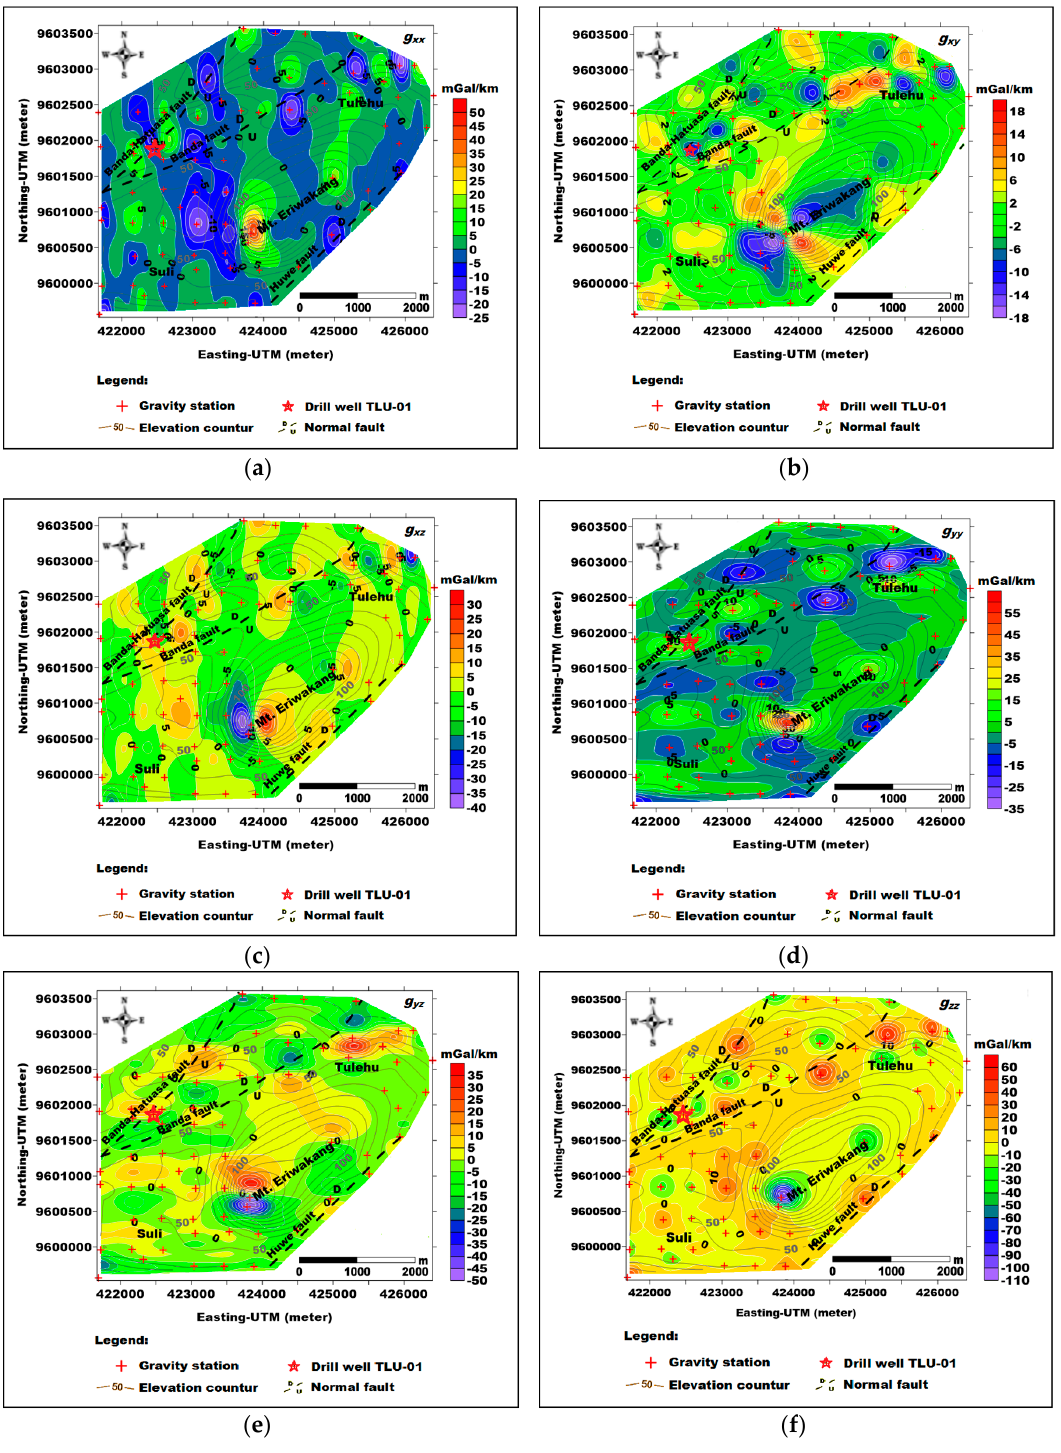
Figure 13. The gravity gradient tensor in Suli and Tulehu geothermal areas, ( a ) g xx ; ( b ) g xy ; ( c ) g xz ; ( d ) g yy ; ( e ) g yz ; ( f ) g zz . ( d ) g yy ; ( e ) g yz ; ( f ) g zz